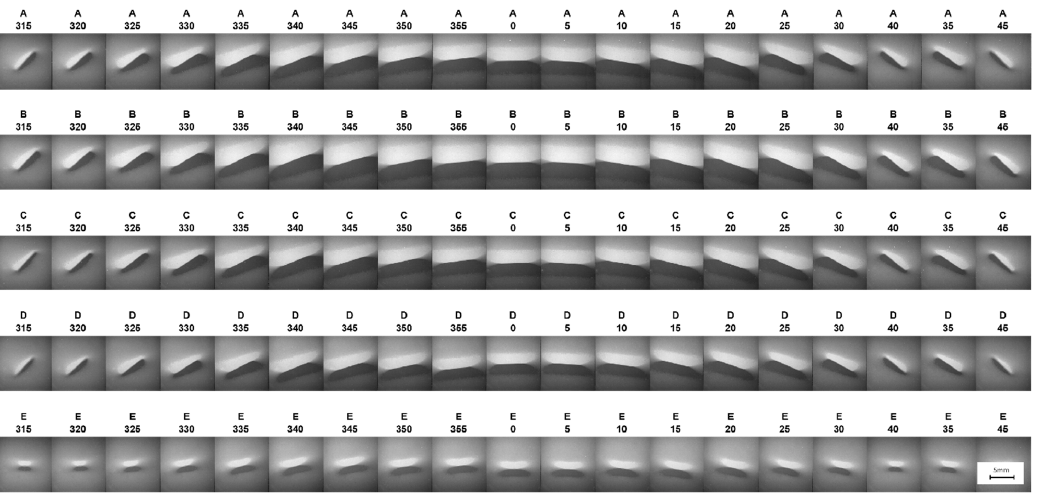
Figure 4. Magneto-optical image from MONDI system experiments.